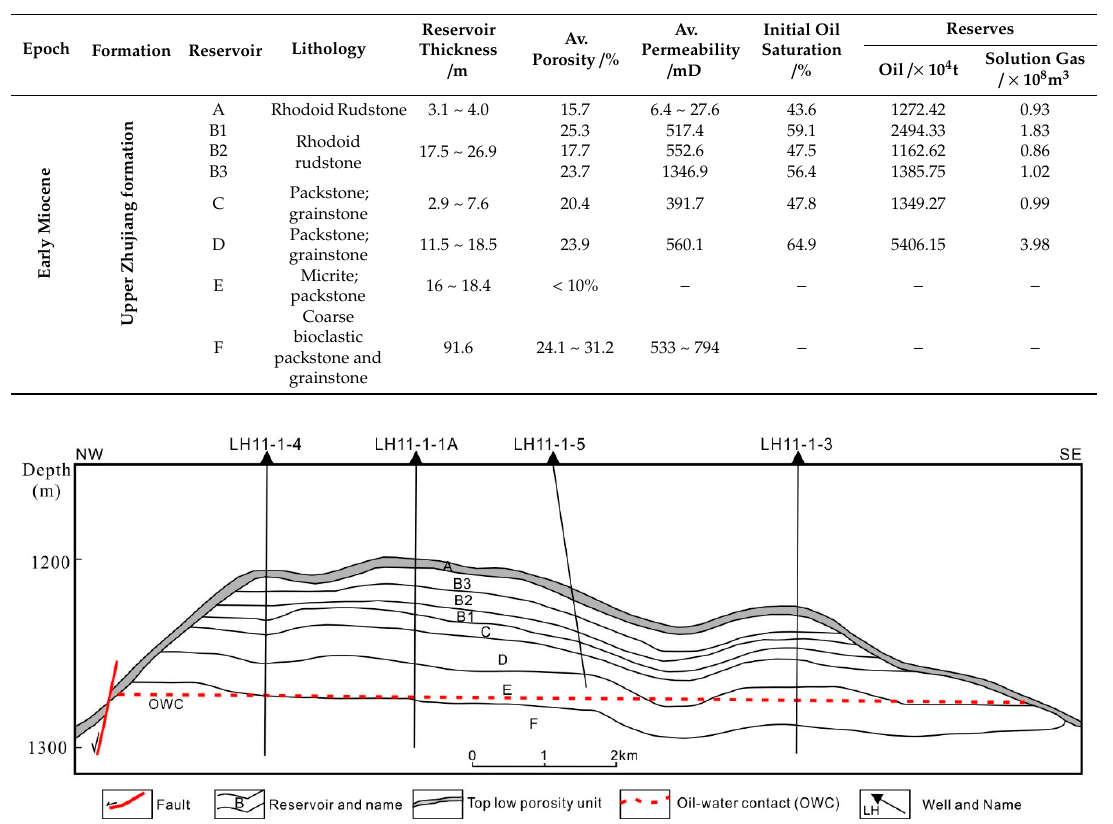
Table 1. Reservoir characteristics of the LH oilfield [17,22].